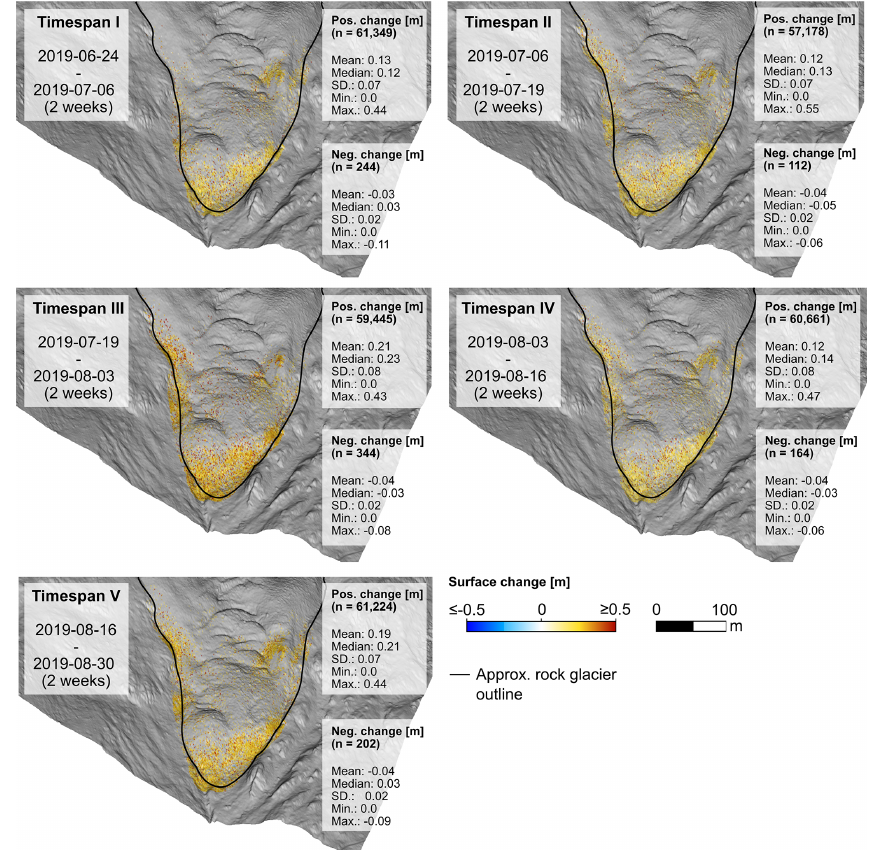
Figure 14. Magnitudes of surface change in flow direction derived from the correspondence-driven plane-based M3C2 for 2-week time spans. A hillshade derived from airborne laser scanning data is used as base layer in all subfigures. As the CD-PB M3C2 algorithm favours confident detection of small-magnitude changes over full point-wise change quantification, change information is more dense at the steep rock glacier front where high point density, spatial coverage, and spatial overlap between point clouds of two epochs could be achieved with TLS-based data